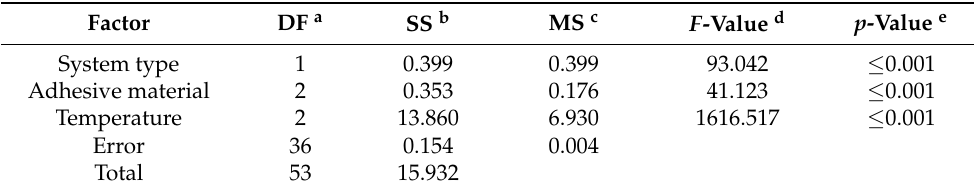
Table 4. ANOVA analysis for interlayer bond